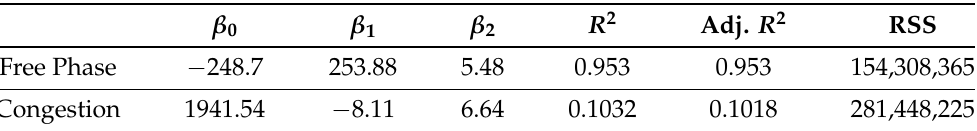
Figure A7. Flux vs. occupancy: RSS analysis. Table A3. RSS analysis with two clusters with flux, occupancy and speed. β 0 is the value of the intercept, β 1 the occupancy, and β 2 the speed.